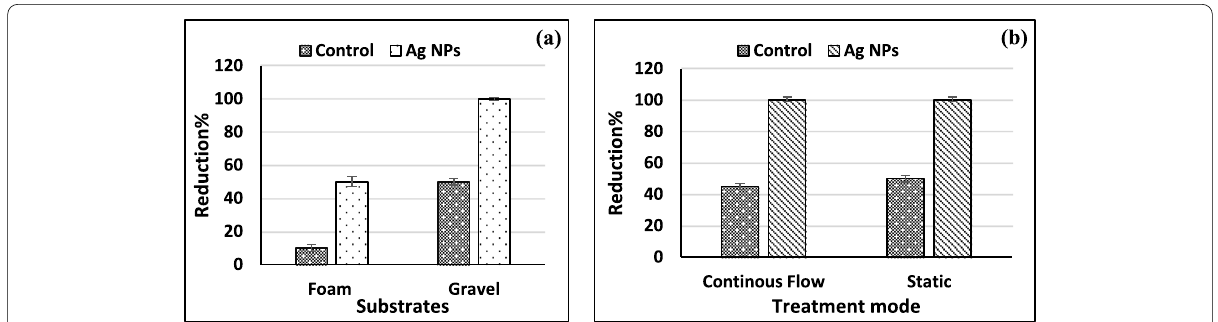
Fig. 6 Reduction percentage of total coliform of wastewater using two different substrates loaded with Ag NPs in column experiment after 6 h compared to unloaded control ( a ). Reduction percentage of total coliform of wastewater using two different disinfection modes of Ag NPs loaded limestone gravel column after 6 h in comparison to unloaded control ( b ). Error bar indicates standard